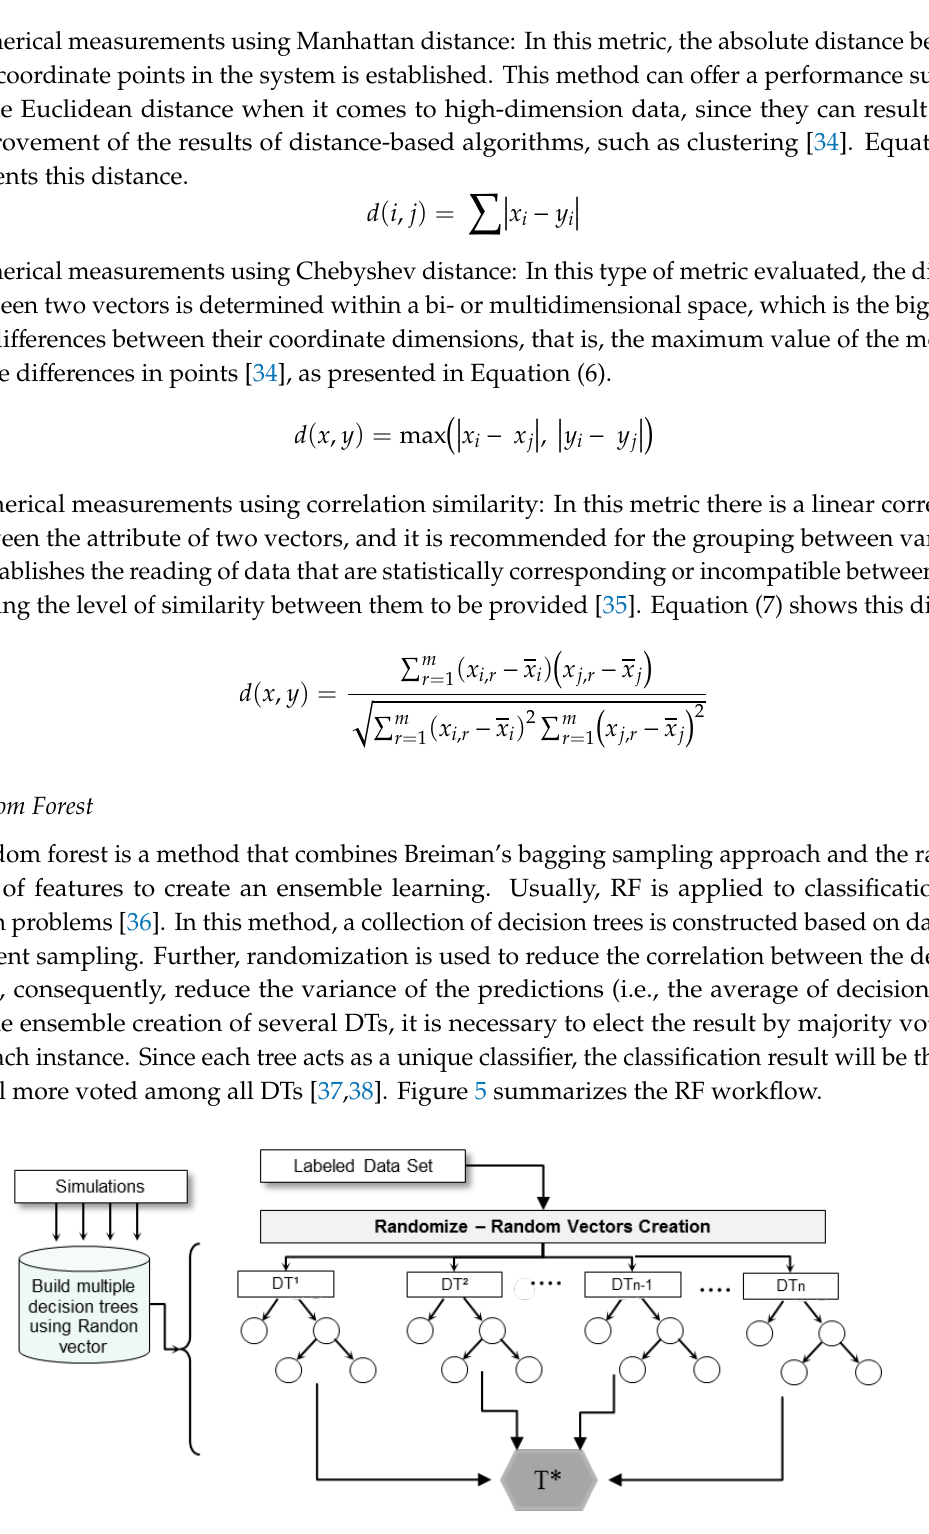
Figure 5. Random forest schematic example. Where T* is majority voting to classify each instance. [36–38].